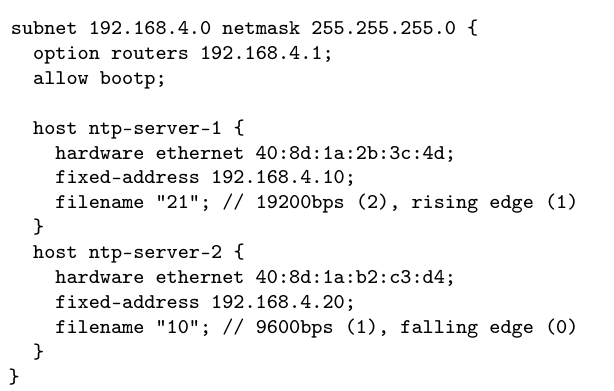
Figure 14. Sample dynamic host configuration protocol (DHCP) server configuration. Internet systems Figure 14. Sample DHCP server configuration. ISC DHCP server format. consortium (ISC) DHCP server